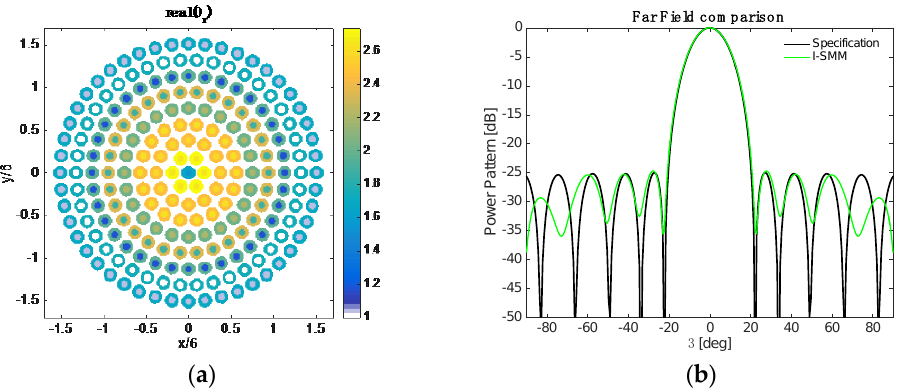
Figure 6. Synthesis of permittivity values for a GAM-based lens composed of layered inclusions [ τ = − 0.8116 + j1.3241]. ( a ) Real part of the permittivity function; ( b ) Radiated far field.